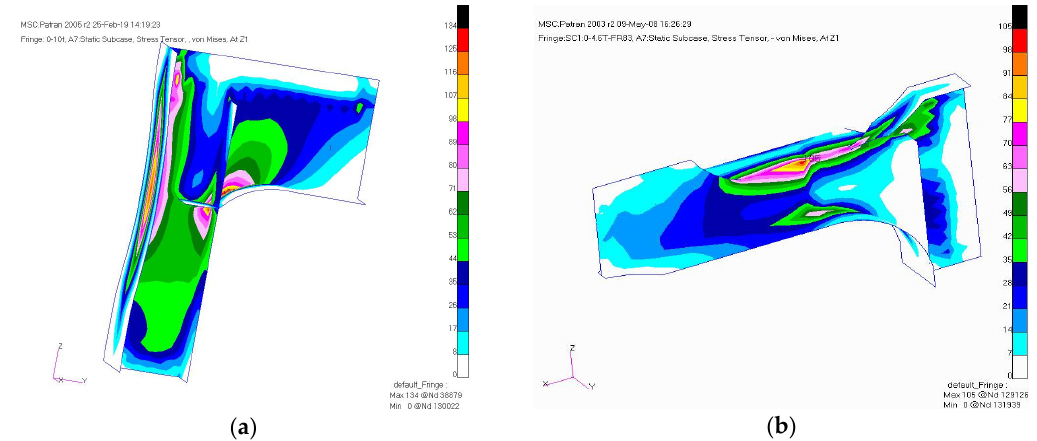
Figure 5. Stress distribution of the following fatigue test models: ( a ) Model 1 and ( b ) Model 2.